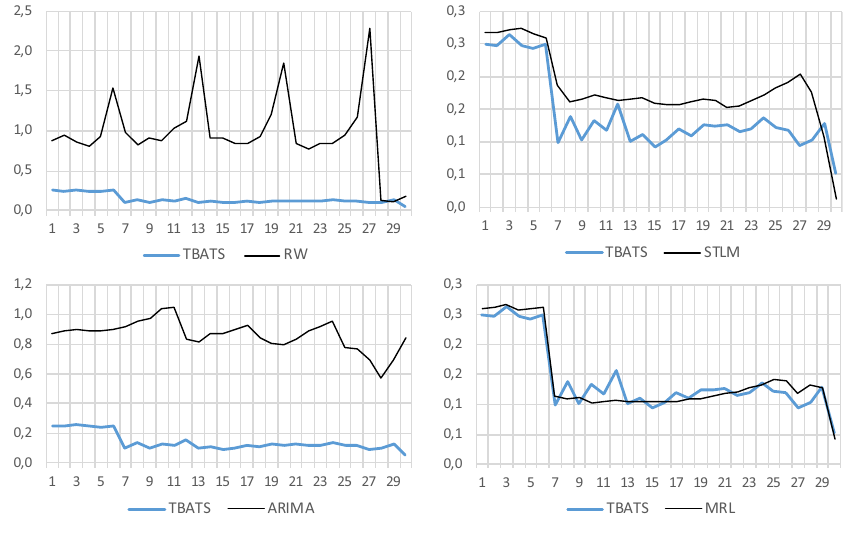
Fig. 11 RMSE daily forecast rolling